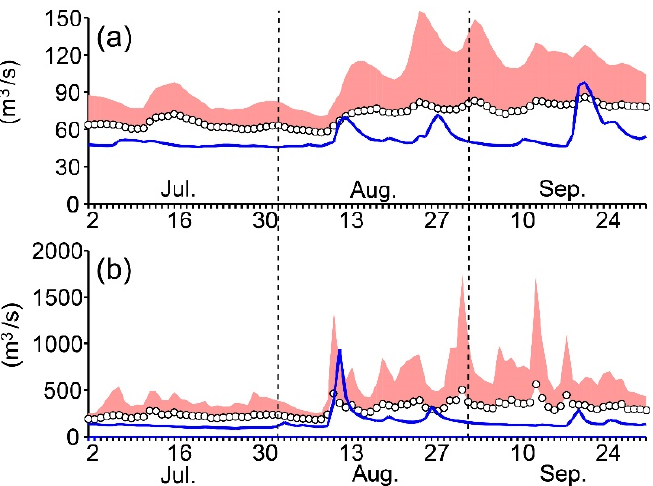
Figure A1. Daily discharge from the ( a ) Kushiro River and ( b ) Tokachi River (thick blue line) in 2021. Climatological daily means (1992–2020) and means plus one standard deviation are denoted by open circles and red shading, respectively.